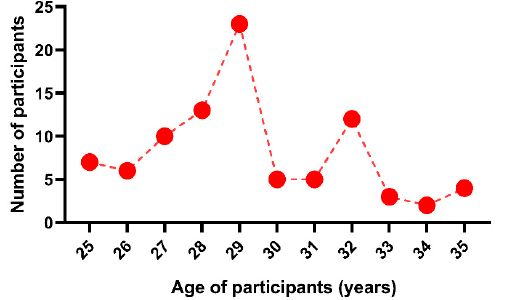
Figure 3. This graph shows the number of participants and their Table 2. Usability scale questionnaires average responses of SSB for N = 90.